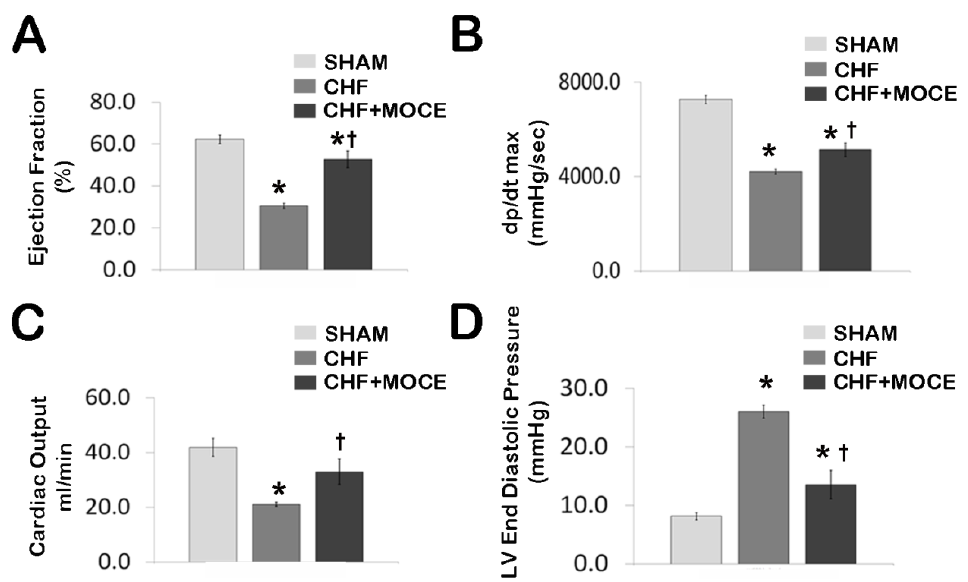
Figure 2. Mocetinostat improved cardiac function in CHF. Hemodynamic parameters were measured in sham, untreated and Mocetinostat (20 mg/kg)-treated CHF and presented in bar graphs; ( A ) Ejection Fraction ( B ) dp/dt max ( C ) Cardiac output ( D ) Left ventricle end diastolic pressure. Sham ( n = 10), CHF ( n = 10), CHF + MOCE ( n = 10). Error bars indicate SE. * , p < 0.05 compared to sham; †, p < 0.05 compared to CHF; CHF, congestive heart failure; LV, left ventricle; dP/dt max , peak rate of left ventricular pressure rise; MOCE,